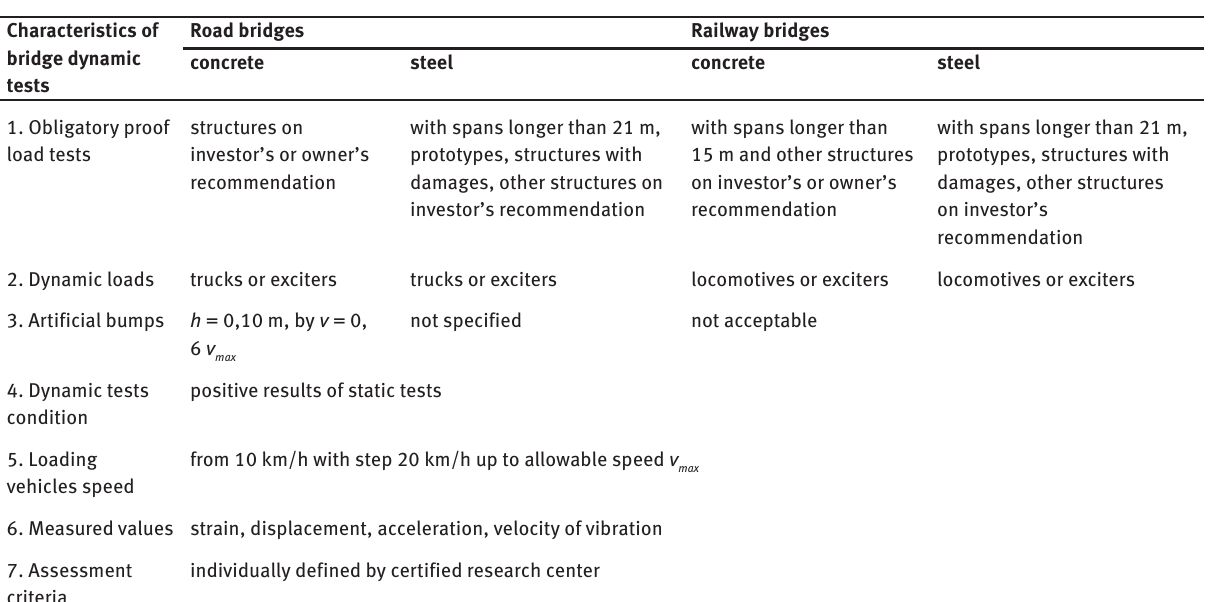
Table 2: Requirements for dynamic tests of bridges in Poland. Characteristics of bridge